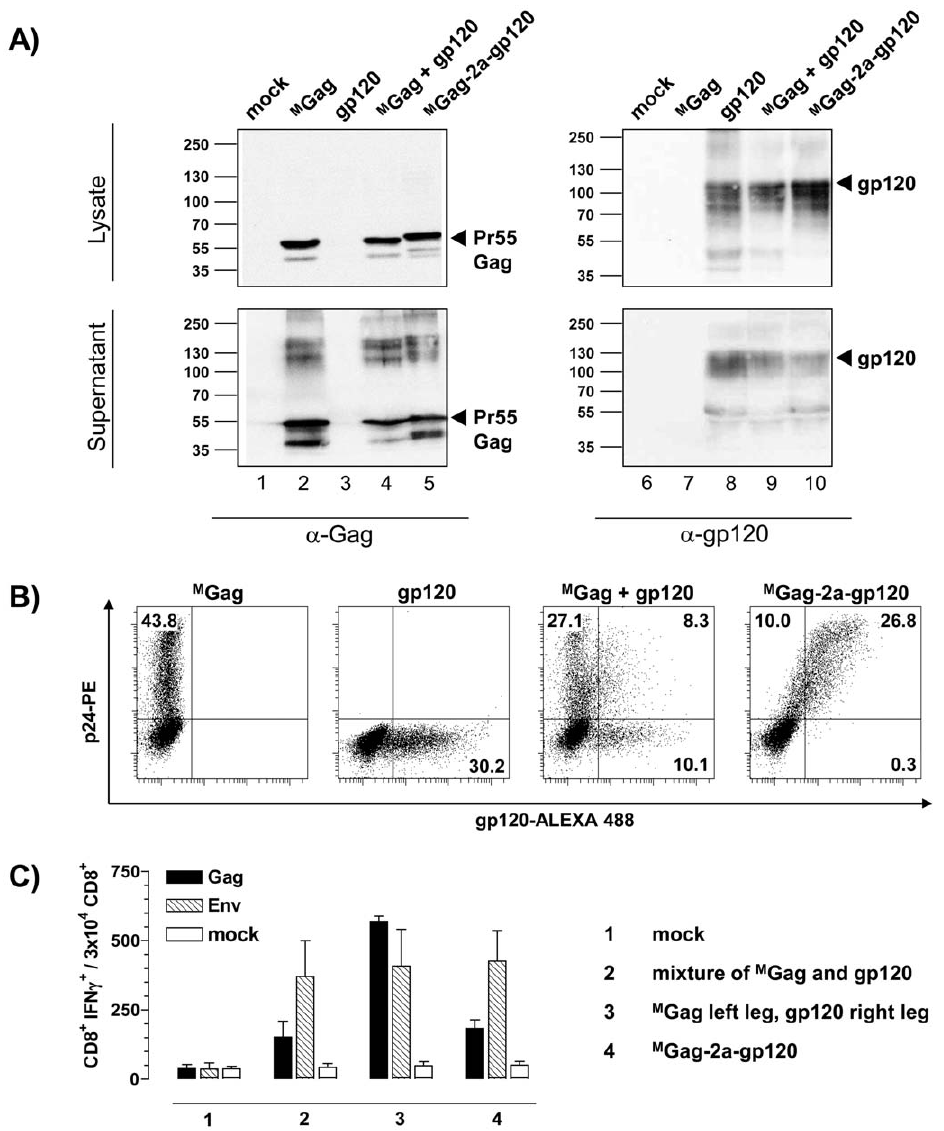
Figure 7. Expression of Gag and Env in co-transfected 293T cells and the effect of administrating Gag-2a-Env on Gag- and Env- specific CD8 + T cell responses. (A) 293T cells were transiently transfected with 3 m g of the indicated plasmid DNA constructs. Following 48 h incubation, TCA-precipitated supernatants and cell lysates were separated by SDS-PAGE and analyzed by immunoblotting using p24-specific (Gag) mouse mAb (CB-4/1), and gp120-specific mouse mAb (MH23), as indicated. Molecular weight markers and positions of the detected proteins are indicated. mock: non-transfected 293T cells. (B) 293T cells were transiently transfected with equimolar amounts of the indicated plasmid DNA constructs. At 48 h post transfection, cells were permeabilized, stained with anti-p24-PE and/or anti-gp120-ALEXA 488 and analyzed by flow cytometry. (C) BALB/c mice (n=6 per group) were inoculated i.m. with (i) an equimolar mixture of M Gag and gp120 in both legs, (ii) M Gag in the left, and gp120 in the right leg, or (iii) M Gag-2a-gp120. After 12 days, spleen cells were isolated and tested for specific cellular immune responses by measuring IFN c production after stimulation with Gag (black) and Env (hatched) specific peptides as above. IFN c production was determined using FACS analysis after intracellular staining of IFN c . Cell culture medium served as negative control. Data shown are representative of two